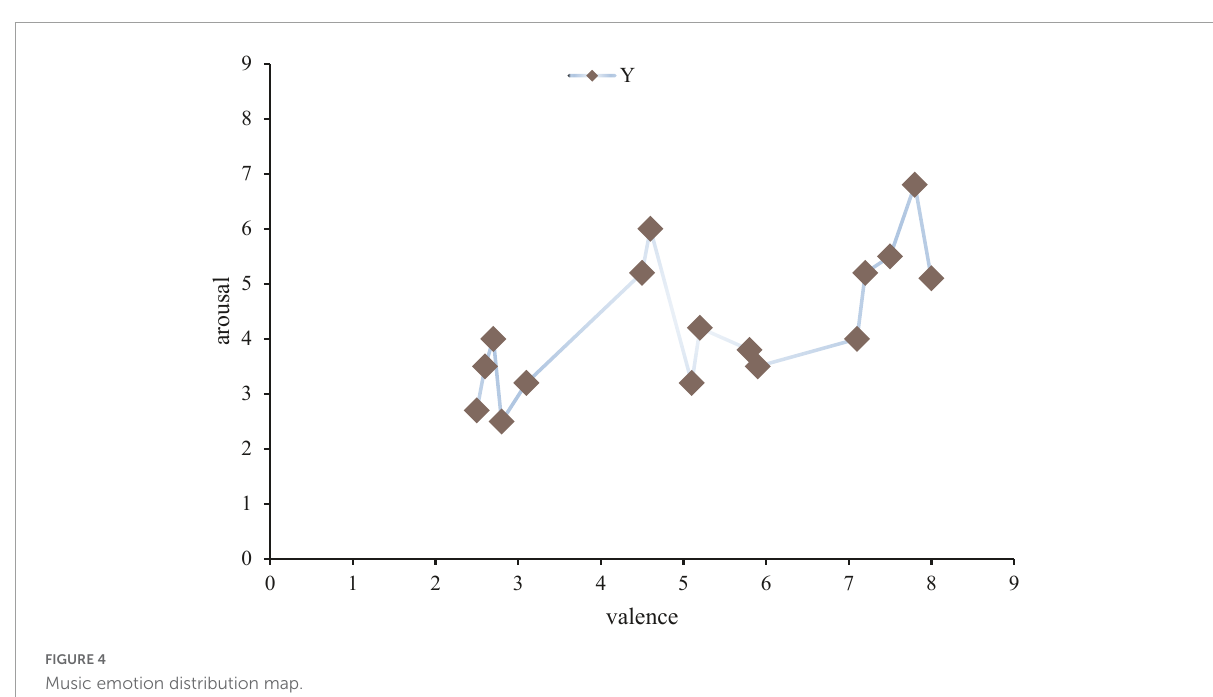
FIGURE3 Triangular filter distribution in real frequency domain.